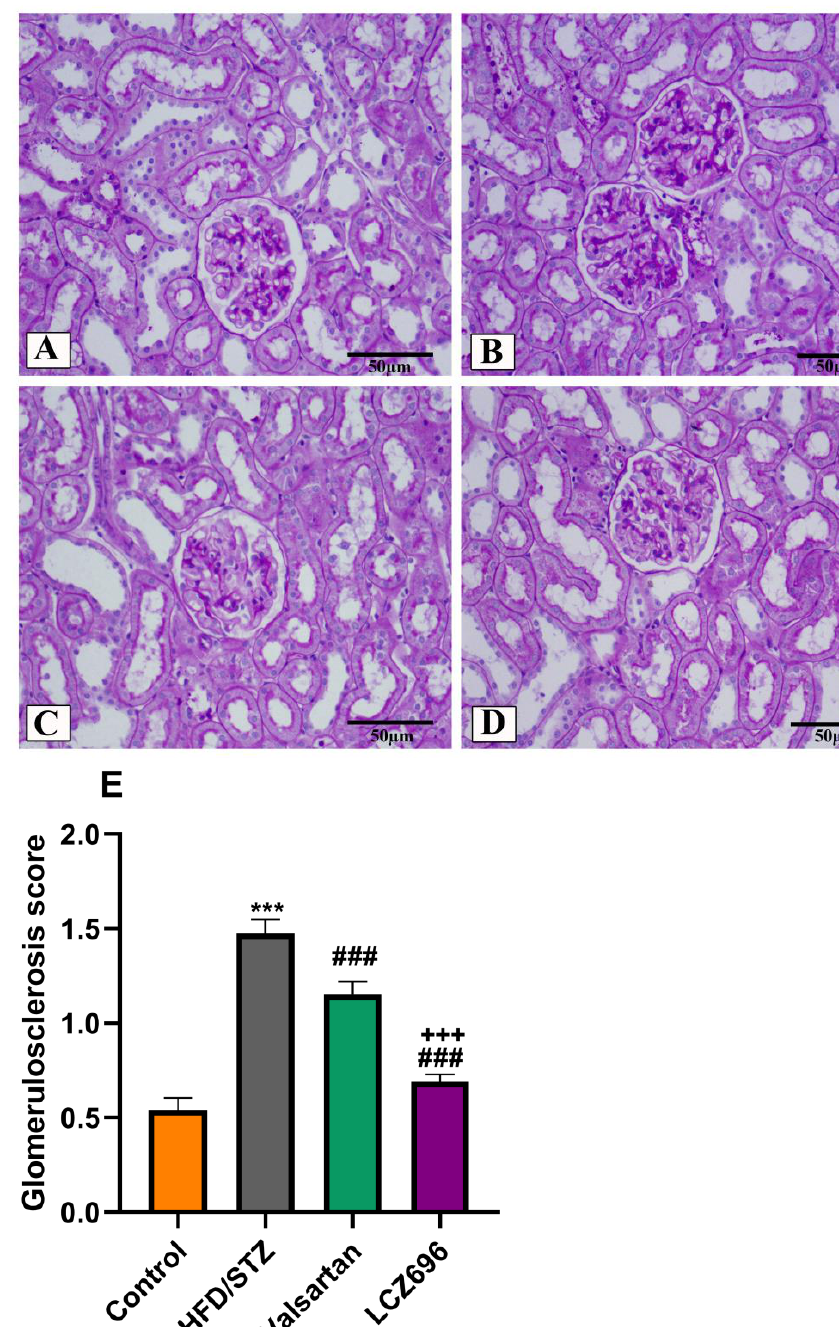
glomerulus (arrow), and infiltration of inflammatory mononuclear cells (head arrow). Glomeruli and renal tubules were significantly improved in the renal cortex of HFD/STZ rats treated with valsartan and LCZ696. Damages to the glomeruli ( E ) and tubules ( F ) in the kidneys of rats from different groups were assessed semi-quantitatively, data are presented as mean ± SEM, n = 6, *** p < 0.001 versus control; ### p < 0.001 and ## p < 0. 01 versus HFD/STZ; + p < 0.05 and +++ p < 0.001 versus valsartan. H&E, scale bar = 50 µm.